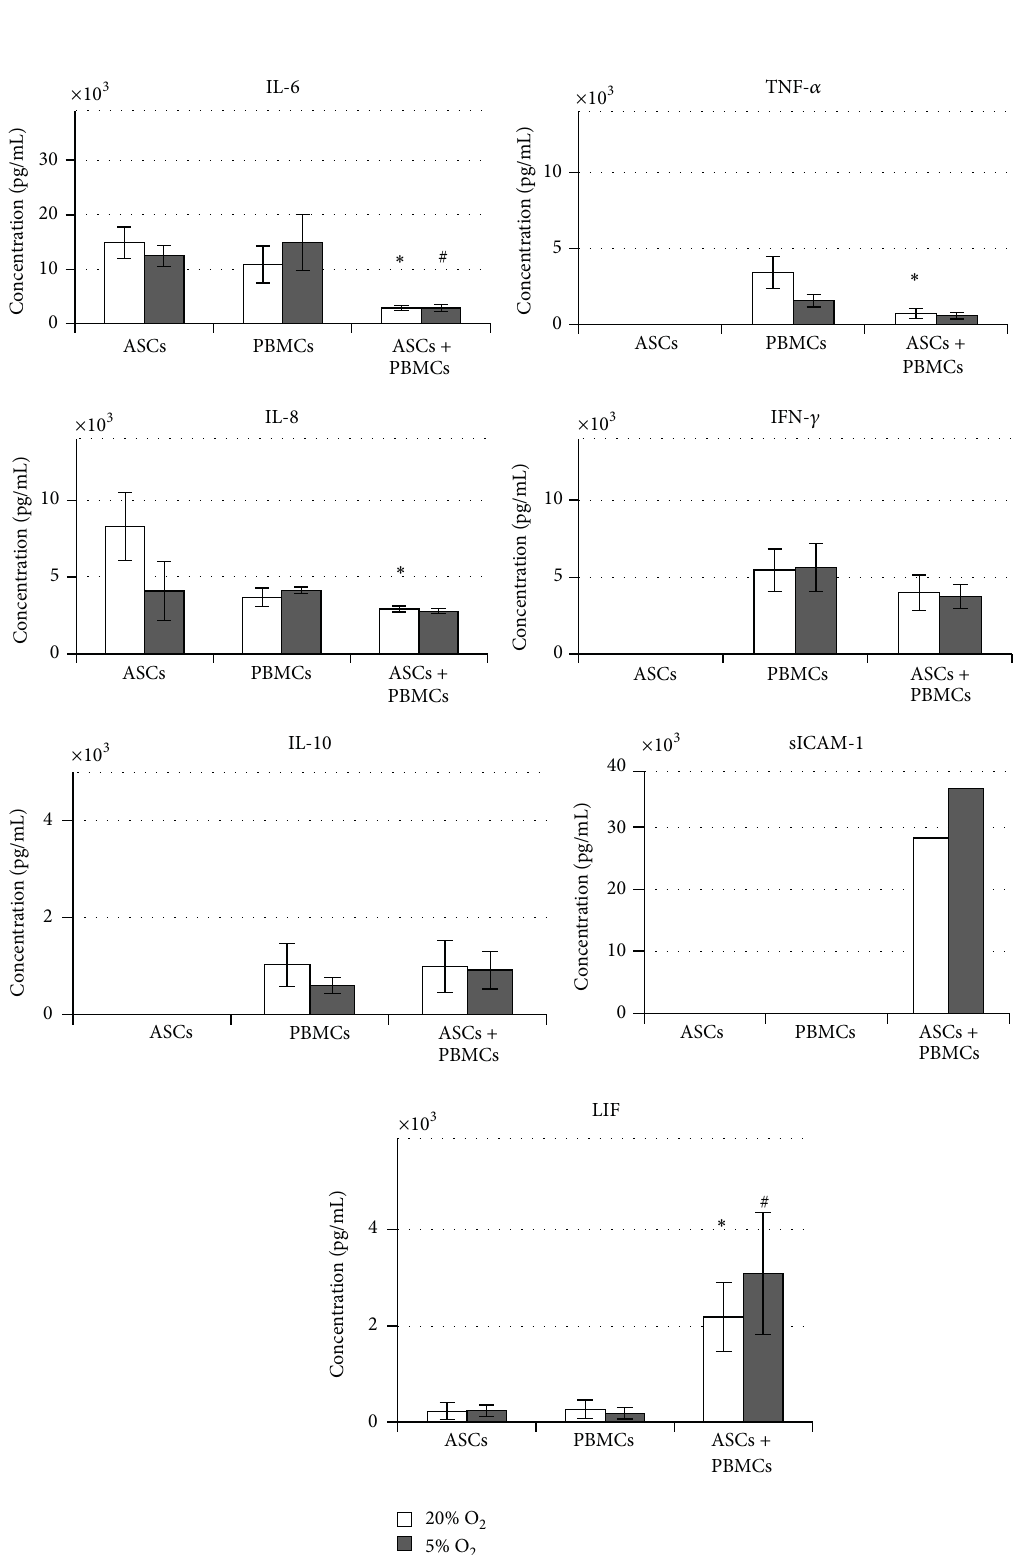
Figure 5: Concentration of soluble mediators in conditioned medium after 72 hrs of culture. ∗ Significant difference between ASC under 20% and 5% O 2 in monoculture. # Significant difference between ASC under 20% and 5% O 2 in